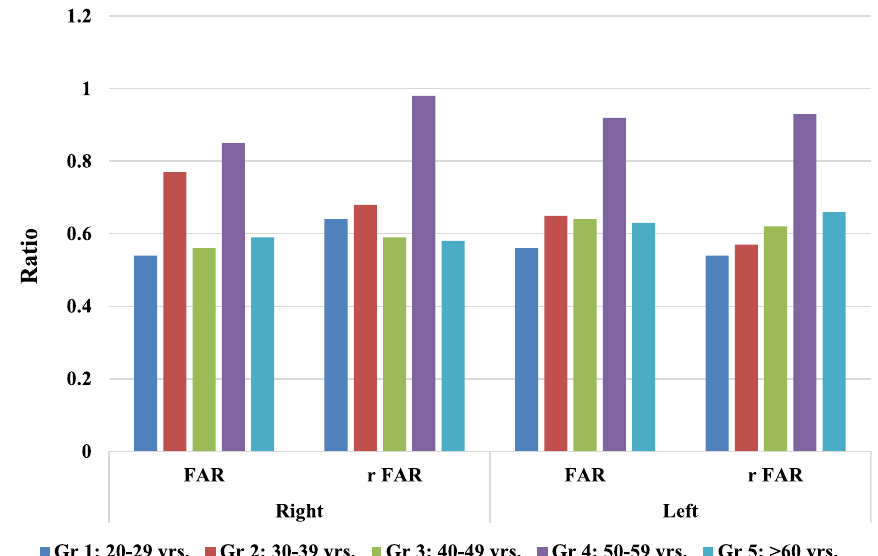
Fig. 5 cVEMP bone conduction FAR and r FAR of the right and left ears of the 5 age groups in this study. There were no statistically significant differences between the right and left ears cVEMP bone conduction FAR or rectified FAR of the any of the 5 age groups in this study ( p >